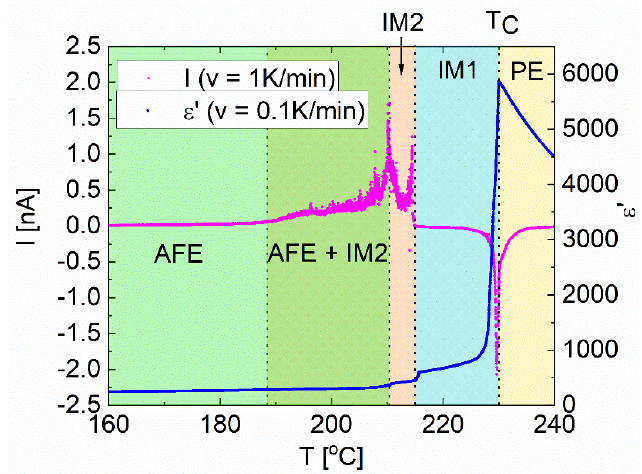
Figure 1. Temperature-dependent permittivity (in blue) and total (primary and secondary) pyroelectric current (in pink) in PbZrO 3 :0.077Nb crystal.